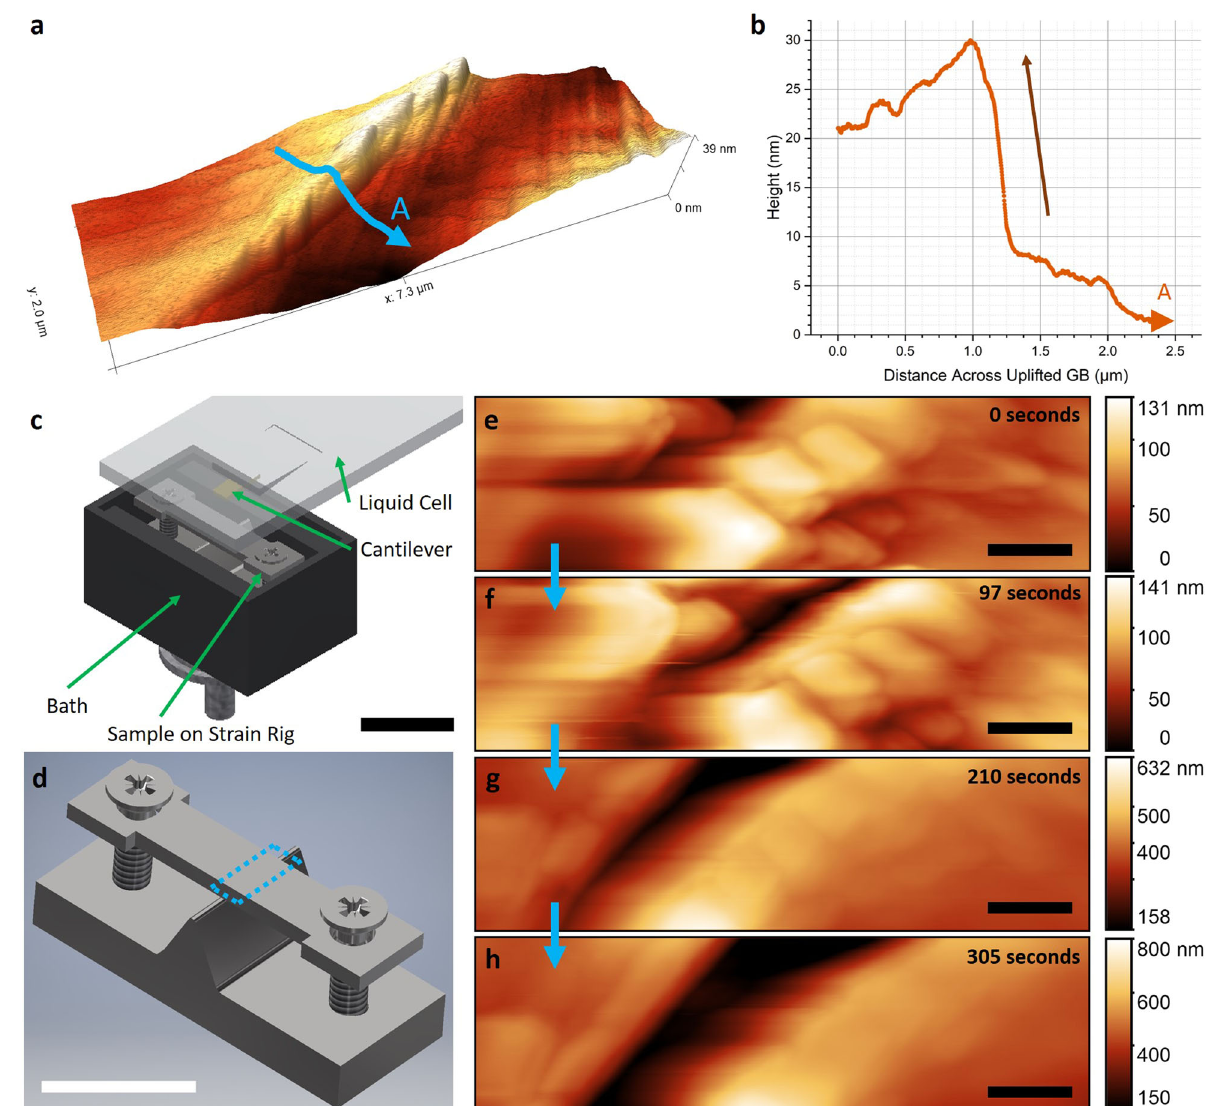
Fig. 3 In situ HS-AFM measurements of IGSCC. a An HS-AFM topographic map showing uplifting of a GB prior to IGSCC occurring, and ( b ) a height pro fi le collected along the line labelled A shown in ( a ) as a light blue line demonstrating the uplift effect. Height measurements have an error of ±15 pm. Schematic images are also shown, ( c ) of the labelled HS-AFM SCC set-up (scale bar: 1 cm), and ( d ) of the three-point strain rig design with the area imaged outlined with a dotted blue box (scale bar: 1 cm), created using Autodesk Inventor 2019. Also, sequential HS- AFM topographic maps showing a crack propagation as IGSCC occurs at: ( e ) 0 s (scale bar: 1 µm), ( f ) 97 s (scale bar: 1 µm), ( g ) 210 s (scale bar: 1 µm), ( h ) 305 s (scale bar: 1 µm). Each topographic map was collected at a frame rate of 2 s − 1 . Additional images showing the set-up are given in Supplementary Fig.